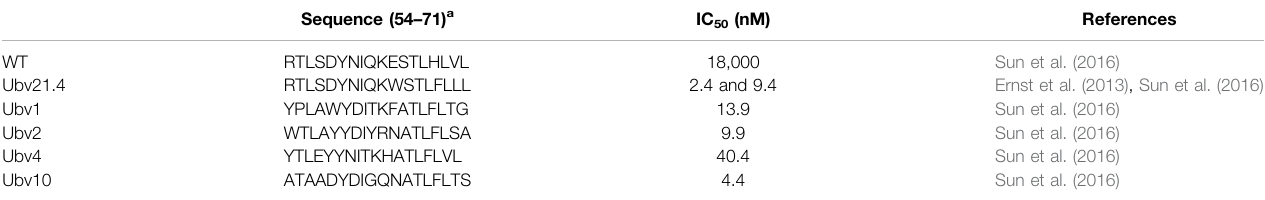
TABLE 4 | The sequence of Ub WT and selected Ub variants targeting USP21.